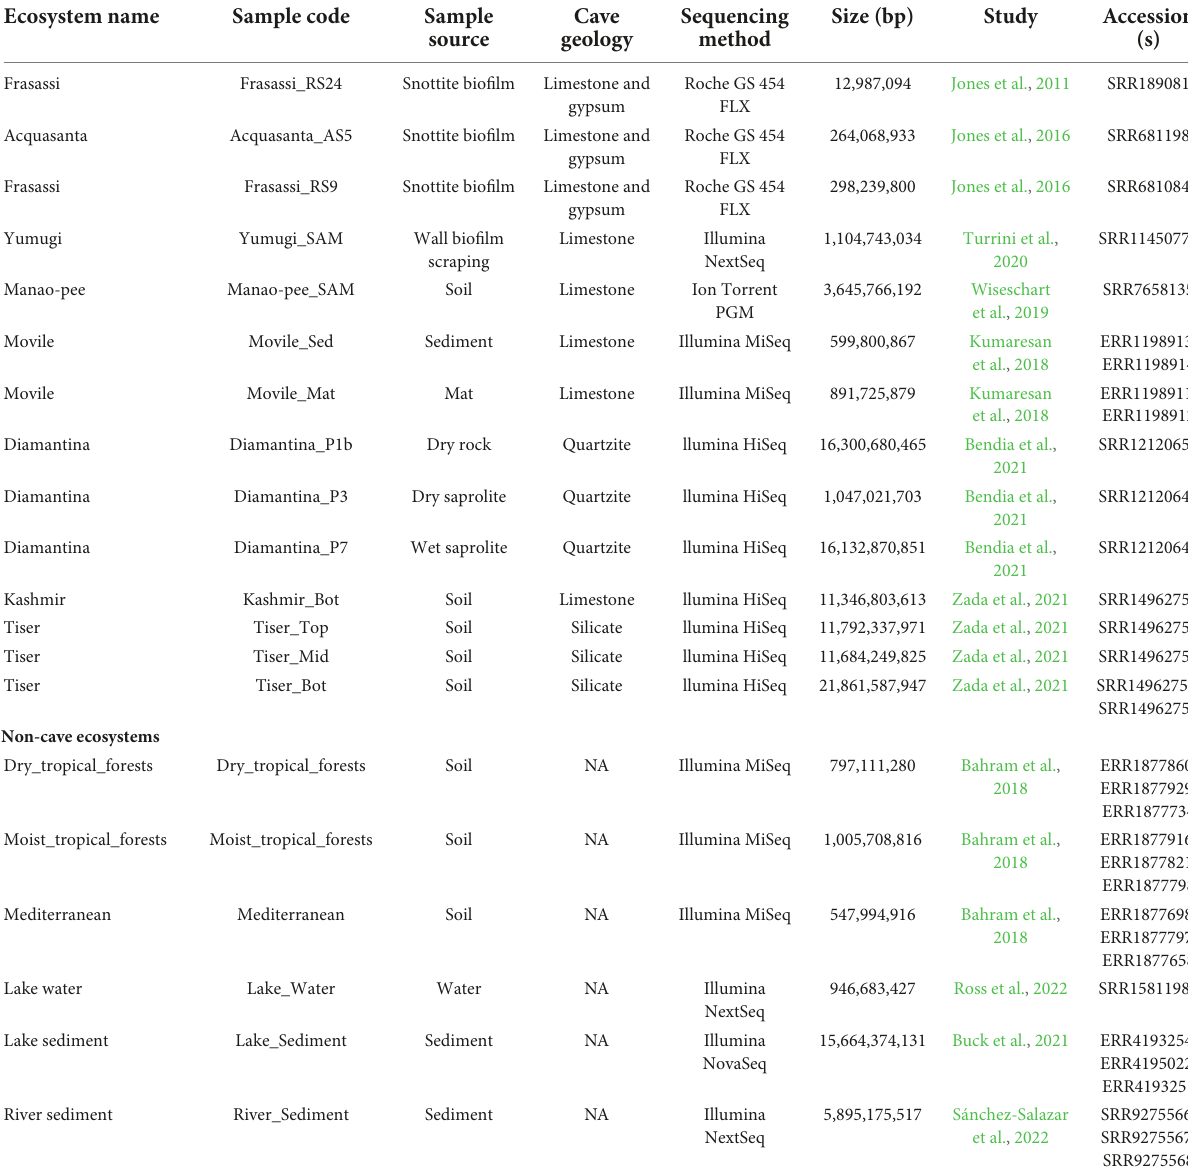
TABLE 1 Summary of shotgun metagenome samples analyzed in this